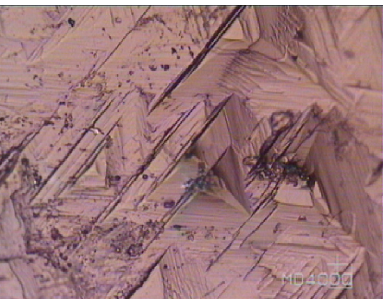
Figure 10. Etching study of Zinc sulphate hepta hydrate (ZSHH)